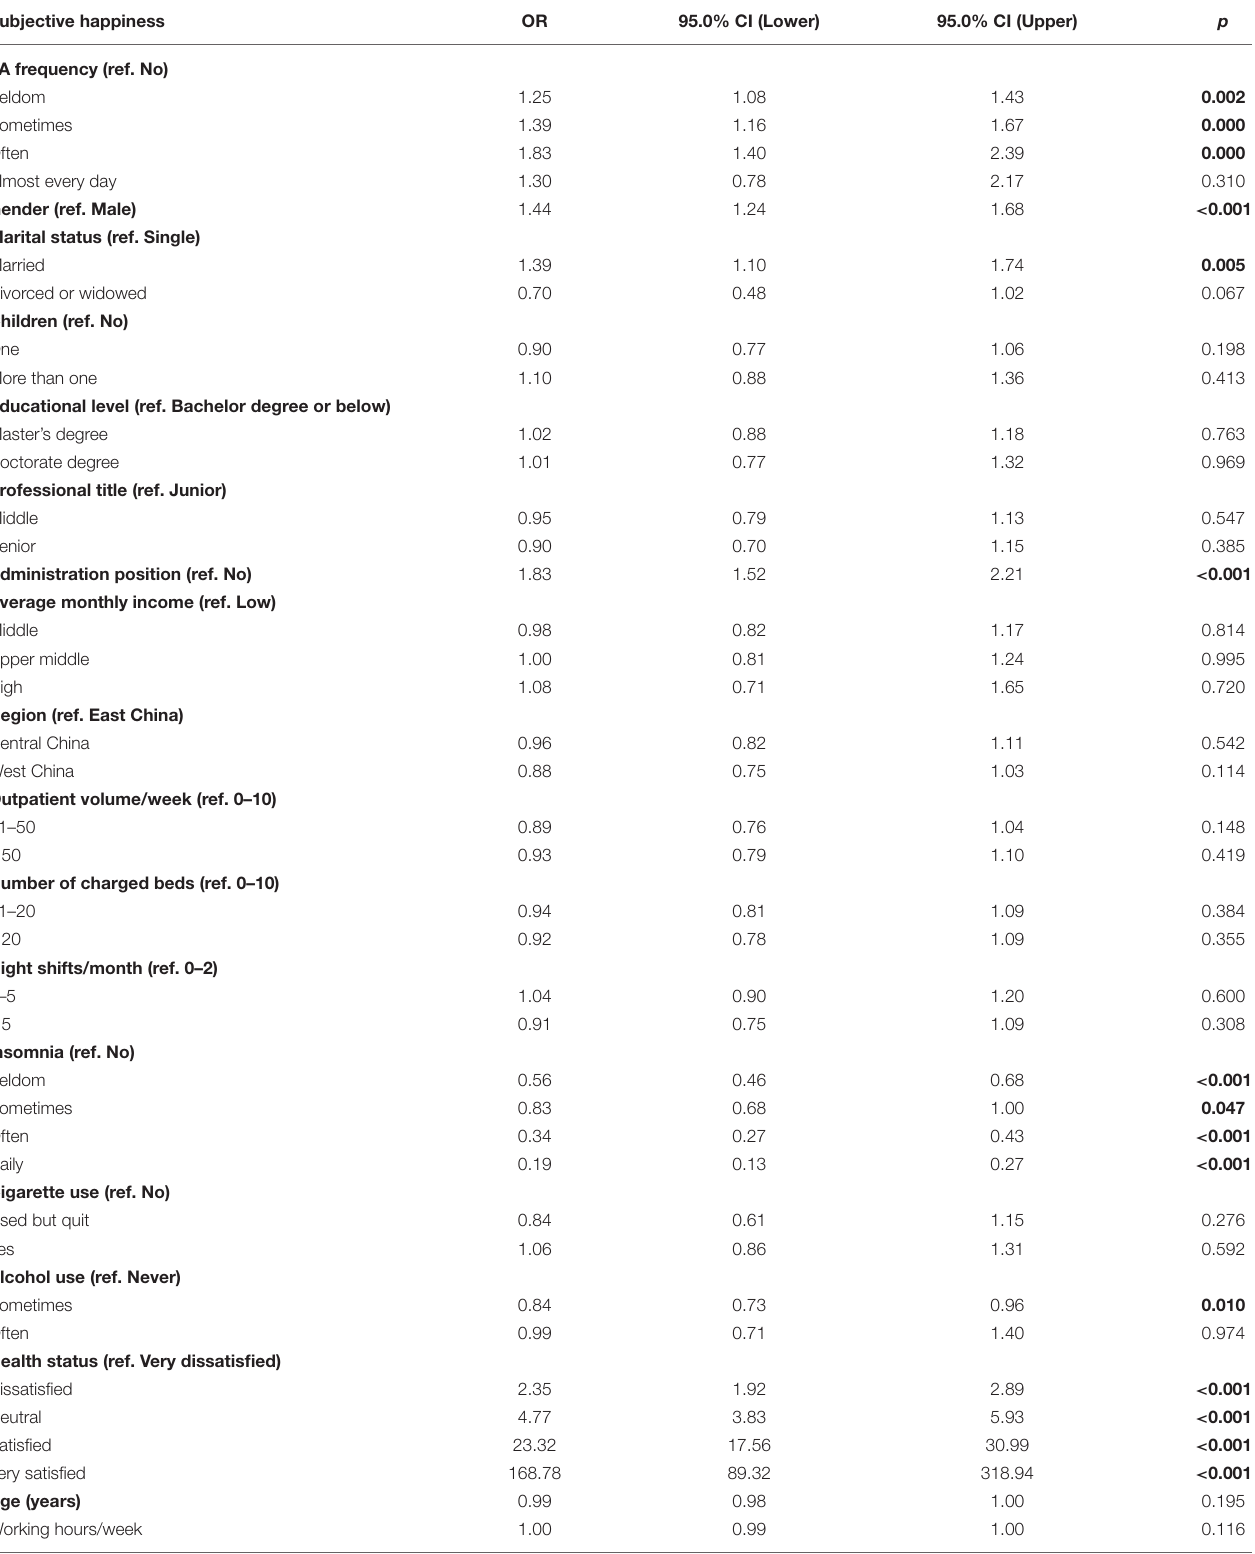
TABLE 4 | Ordinal logistic regression examining factors associated with subjective happiness ( N = 4,520). Subjective happiness